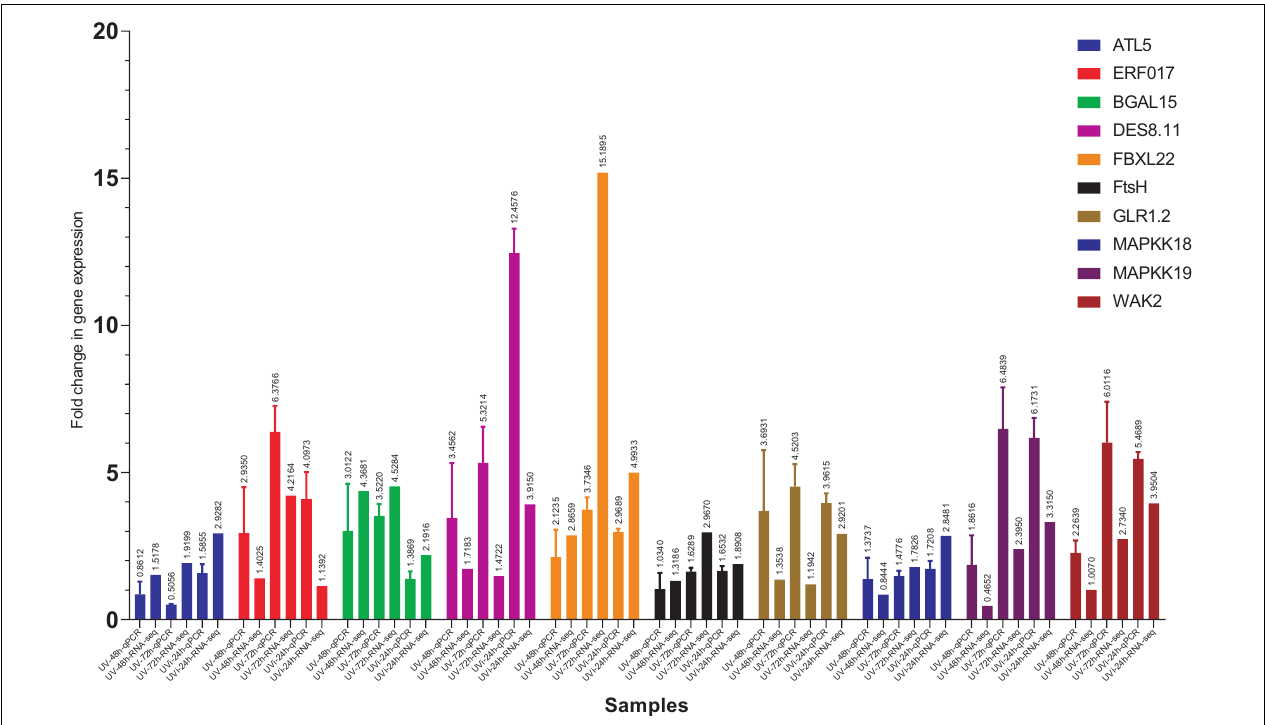
FIGURE 5 | Comparison of gene expression levels between RNA-seq and qPCR. On the X -axis, we have qPCR data coupled to RNA-seq data for each gene and for each treatment: UV-48 h, UV after 48 h treatment; UV-72 h, UV after 72 h treatment; UVi-24 h, UV 24 h after inoculation. C-48h (Control corresponding to treated 48 h after UV) was used as a